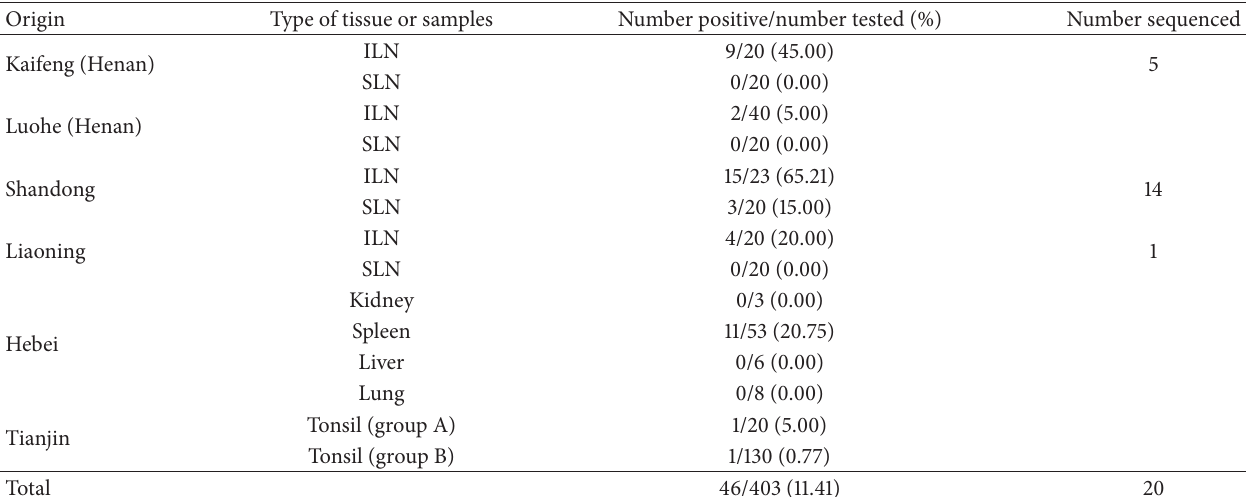
Table 1: Prevalence of PBoV detected by PCR in the pig samples in